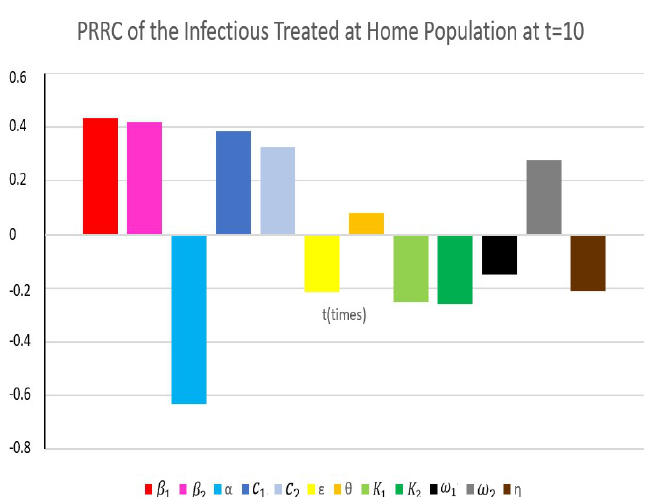
Figure 7. PRCC of the infectious population treated at home.